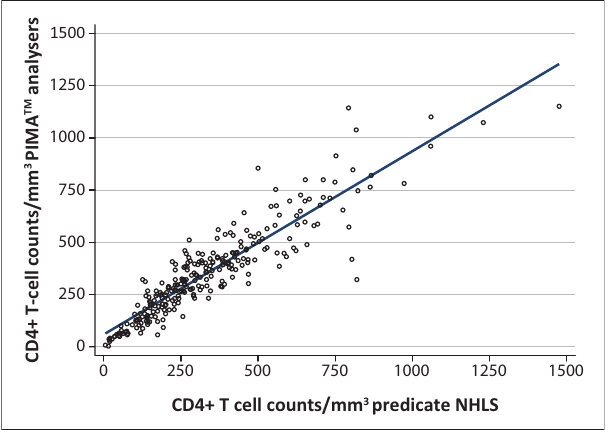
FIGURE 1: Comparison of CD4+ T-cell counts obtained by the PIMA TM analysers and the National Health Laboratory Services in whole-blood